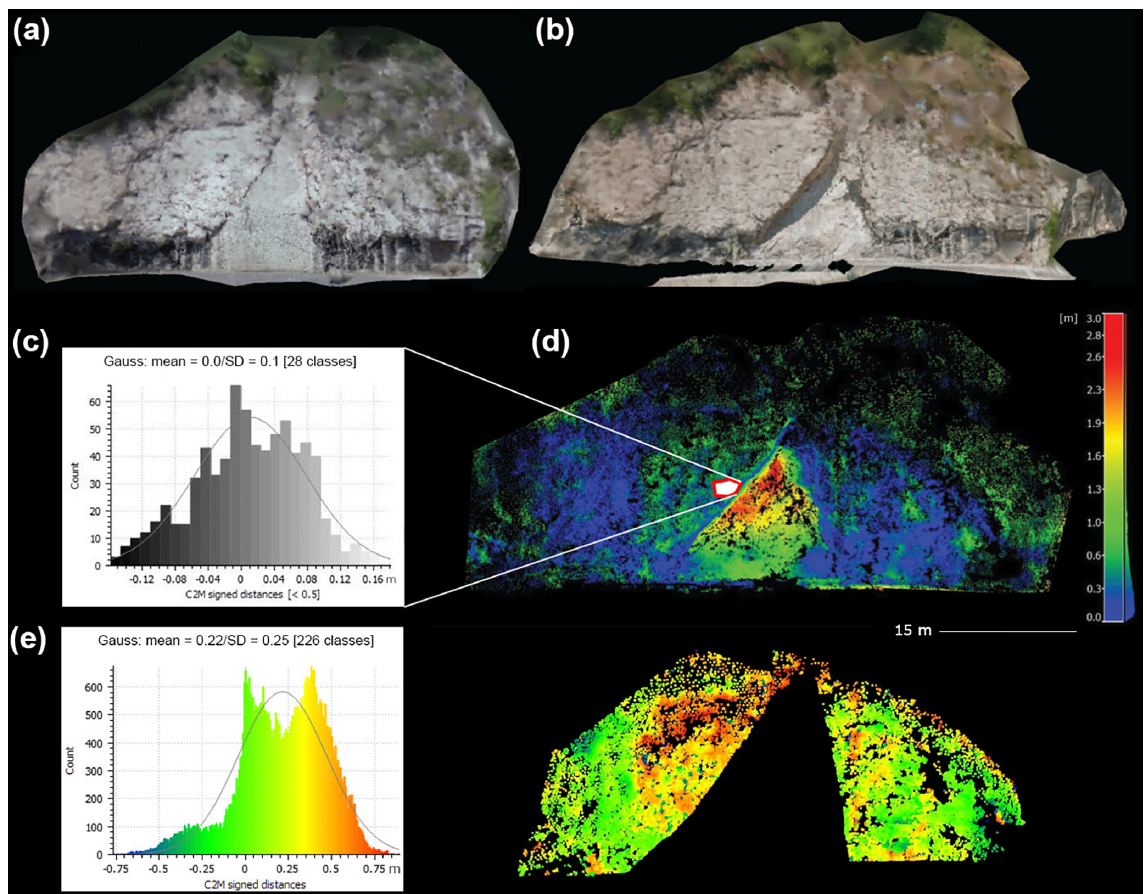
Figure 4. Results at site 1, Basse Corniche. (a) Three-dimensional model produced with GSV images taken before the event in 2008. (b) Three-dimensional model produced with GSV images taken after the event in 2014. (c) Statistics on a small part of the wall (red polygon in panel d ) of 7510 points between the two point clouds with the point-to-mesh strategy in the CloudCompare. (d) Comparison of the two point clouds of 2008 and 2014 on the entire surface of the 3-D point clouds. The maximal horizontal depth of the cliff is about 3.9m. (e) Comparison of the two point clouds of 2008 and 2014 on the entire stable parts of the cliff (i.e. without vegetation) by not taking into account the collapsed wall (black triangle in the centre of the point clouds). The information on the picture source, date, point density and program used is given in Tables 1 and